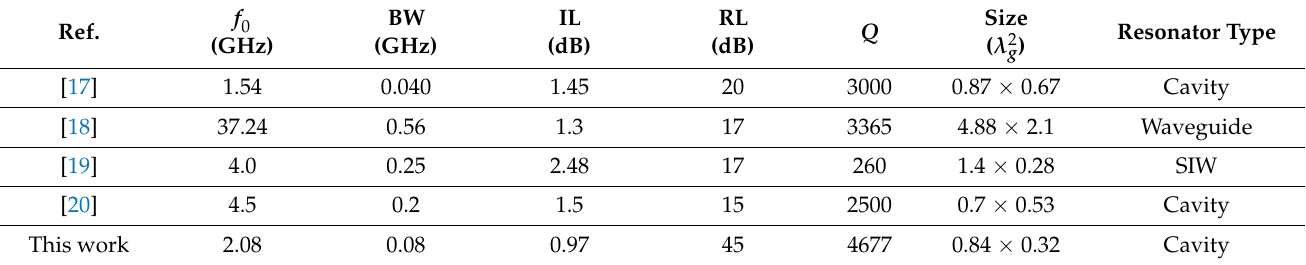
with several recent CL filters for parameters such as out-of-band rejection. Table 2. Comparison of the proposed-filter performances with related published works.